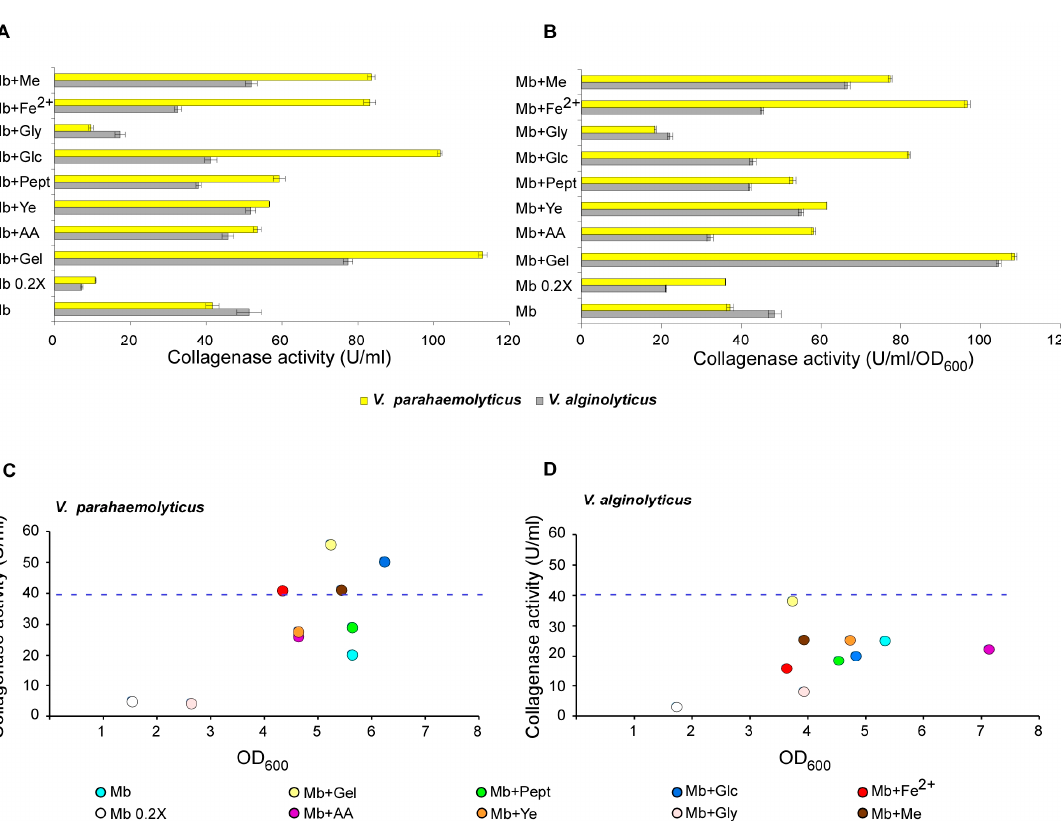
Figure 2. Collagenase production from V. parahaemolyticus and V. alginolyticus in di ff erent culture media. The collagenolytic activity was measured using bovine insoluble collagen as substrate. Collagen was incubated with supernatants from liquid cultures of V. parahaemolyticus and V. alginolyticus , grown overnight in the specified liquid media. ( A ) Collagenase activity measured by colorimetric test. ( B ) Collagenolytic activity normalized with cell density. ( C , D ) Trend of collagenolytic activity with cell density in V. parahaemolyticus ( C ) and V. alginolyticus ( D ).